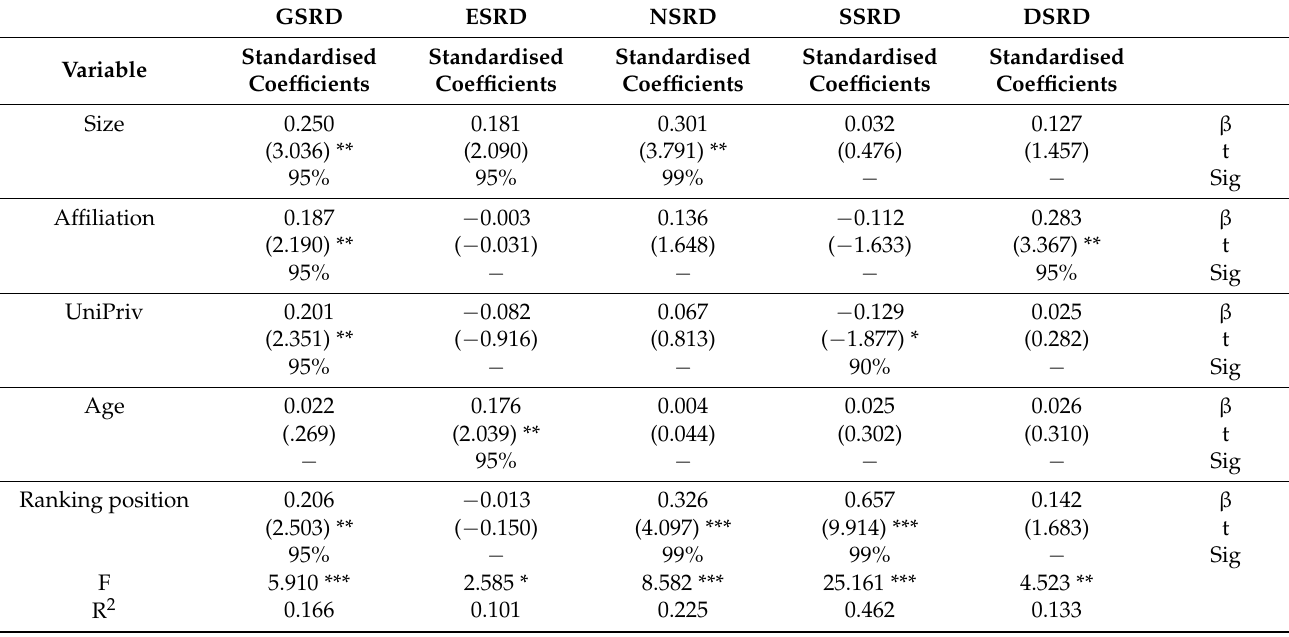
Table 6. Factors underlying the online disclosure of CSR